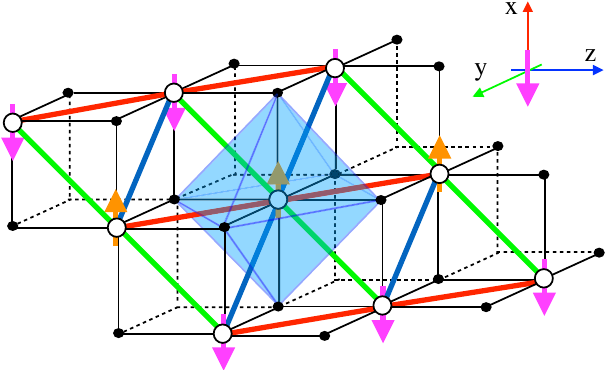
FIG. 11. Same as Fig. 1, side view. The octahedron of ligands is highlighted; cubic axes and bonds of the triangular lattice are shown. Spin ordering corresponds to the stripe- yz phase for the parameters along the gapless K − J line (see text).